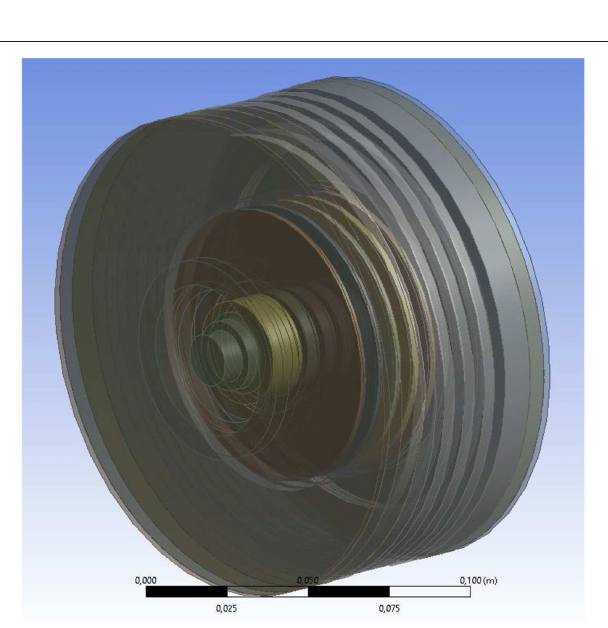
FIGURE 5 | View of the clutch’s geometry for s k = 2: brown color, discs; gray color, casing. velocity ω is the operation of the clutch at a higher power and a smaller area of heat